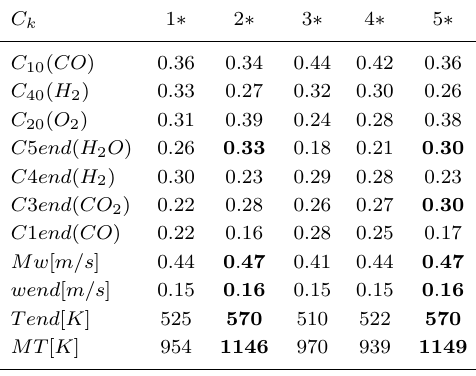
Table 4. Values of Mw,wend,MT,Tend,Ckend,k = 1 , 3 , 4 , 5 , t f =10.